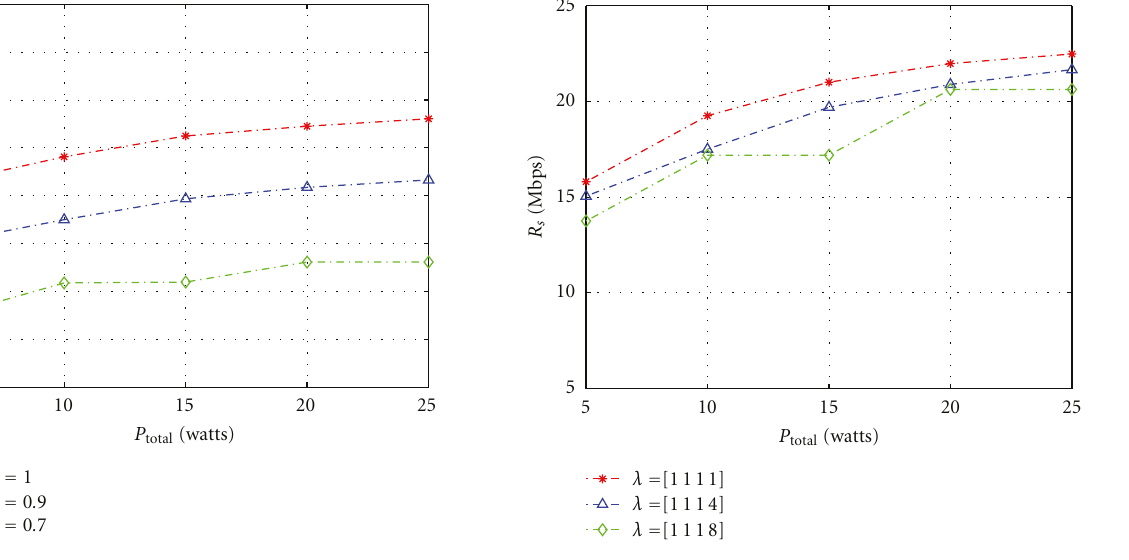
Figure 4: Average total CRU bit rate, R s , versus total CRU transmit power, P total , with I total = 0 . 02W, P m = 5W, and ρ = 0 . 9.